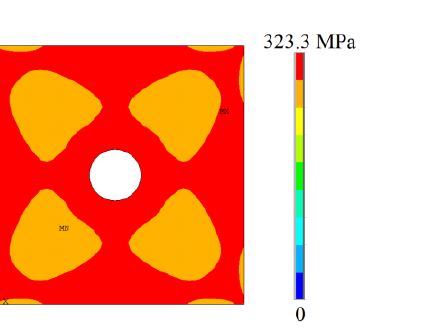
Figure 8. The von Mises stress distribution for the square plate with centered circular hole.